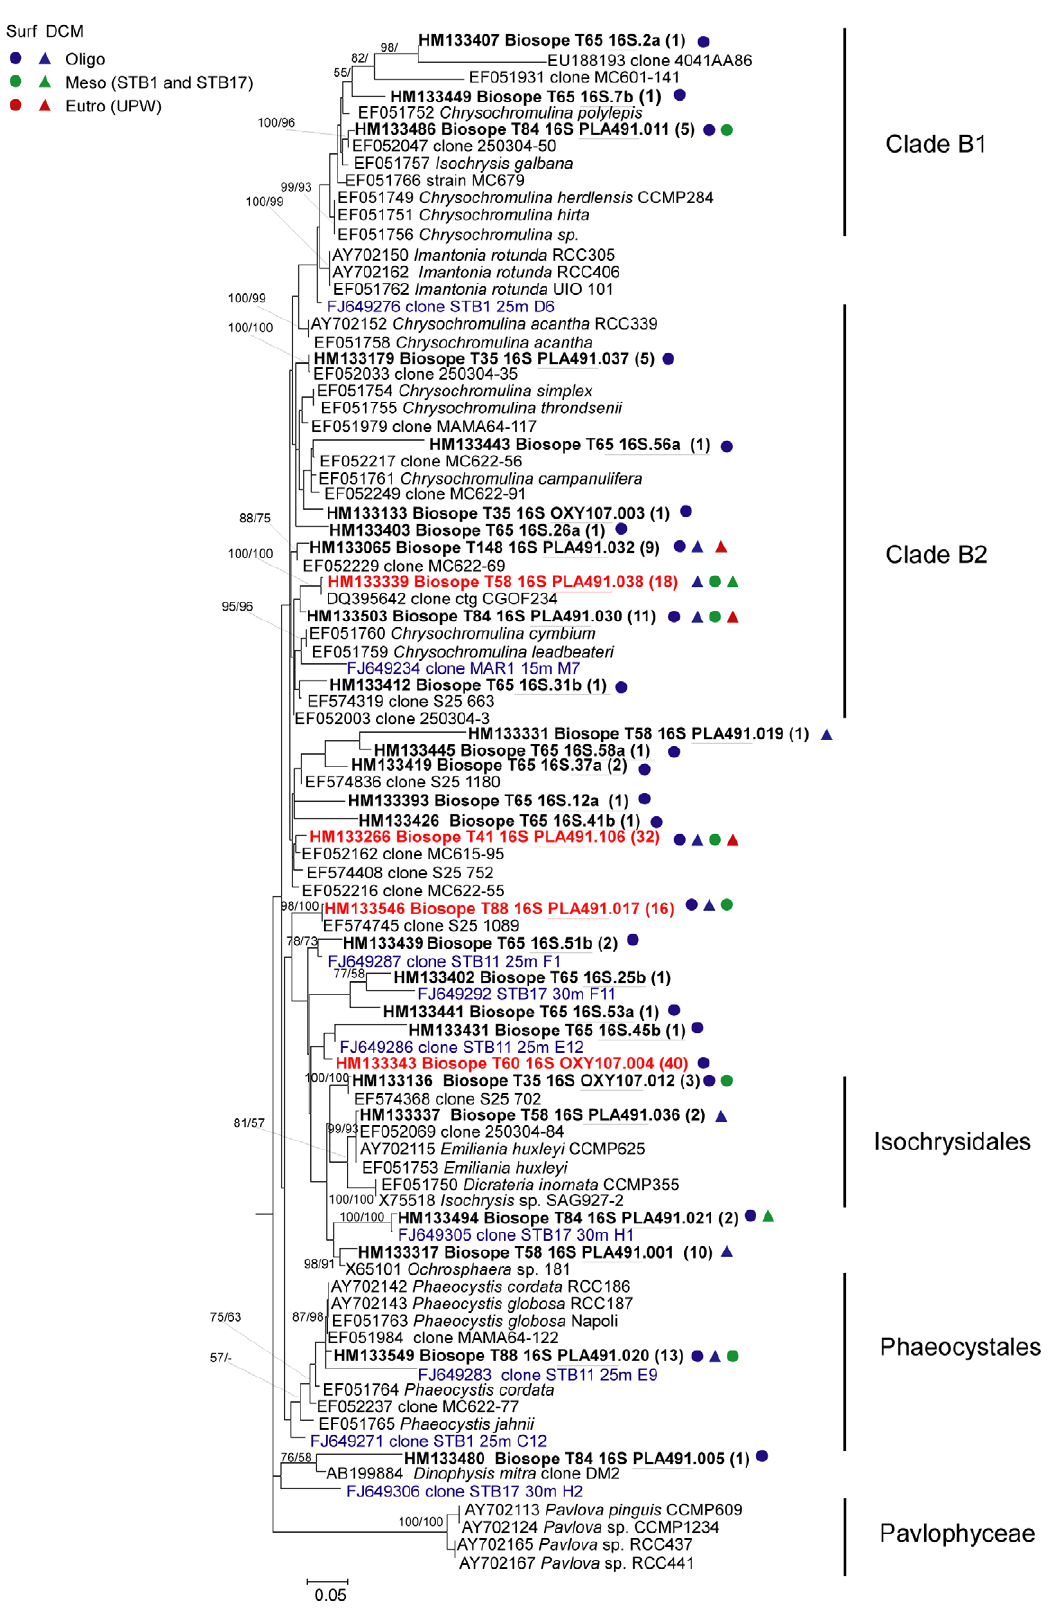
Figure 3. Phylogenetic tree of plastid 16S rRNA gene sequences for Haptophyta. The tree is inferred from 689 positions of an alignment of 89 partial sequences. See legend of Fig. 2 for details.